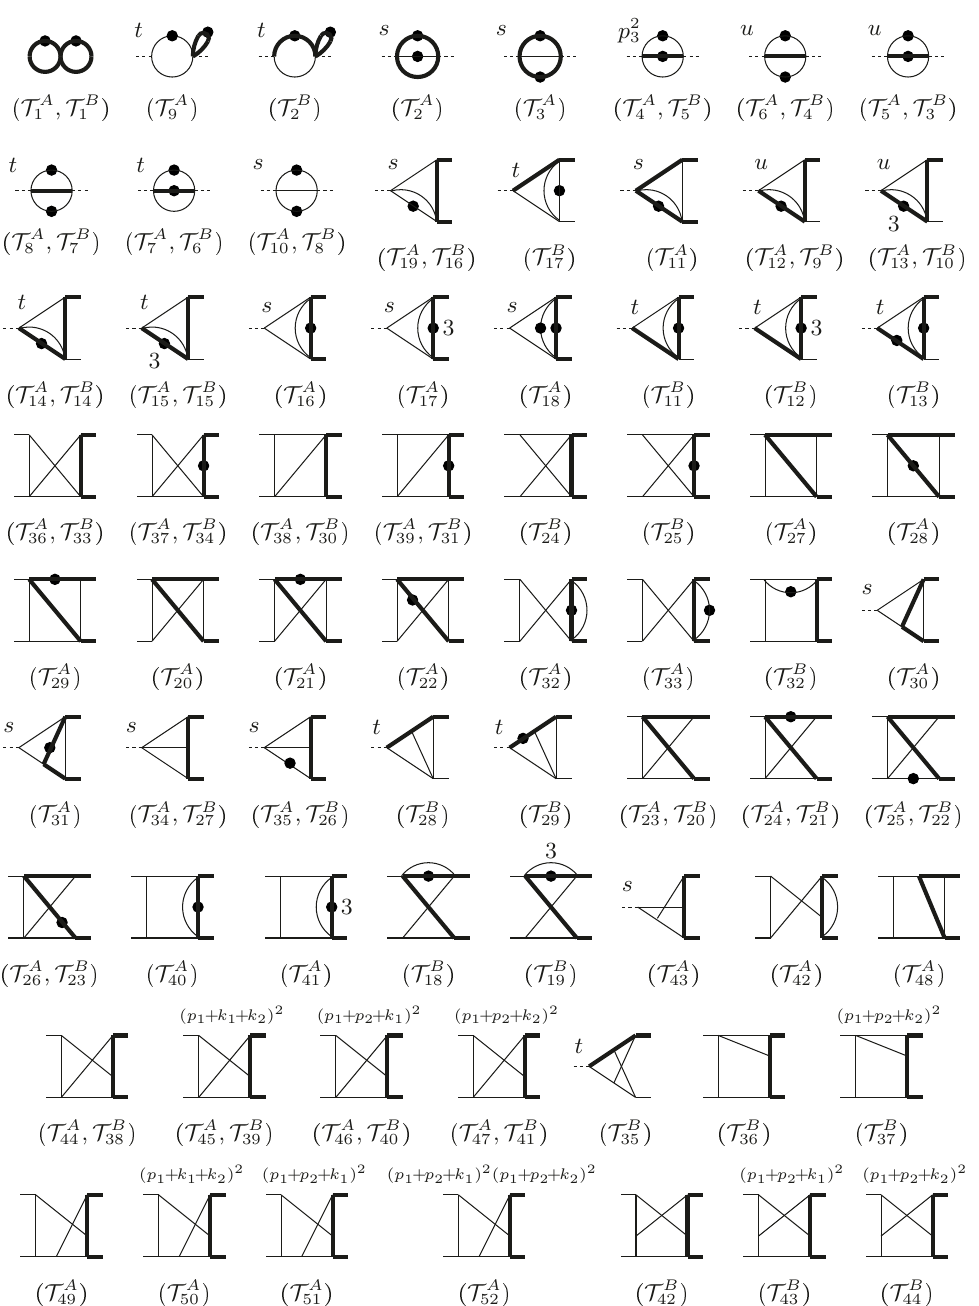
Figure 2 . Master Integrals in pre-canonical form. Internal thin lines represent massless propaga- tors, while thick lines represent heavy-quark (massive) propagators. External thin lines represent massless particles on their mass-shell, p 2 = 0. External thick lines represent massive particles on their mass-shell, p 2 = m 2